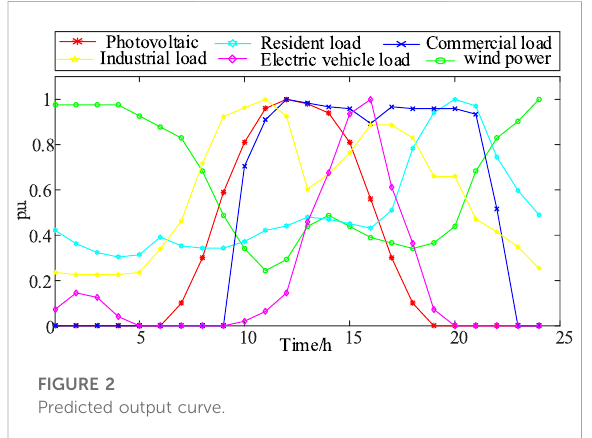
FIGURE 2 Predicted output curve.